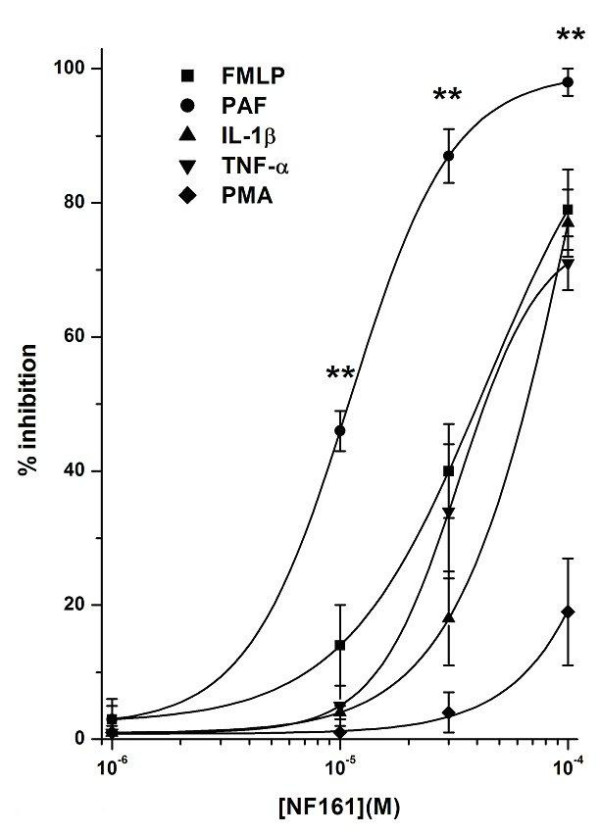
Effects of NF161 on PMN adhesion to HUVEC evoked by PAF, FMLP, IL-1β, TNF-α and PMA. HUVEC were pretreated with increasing concentrations (10-6–10-4M) of the tested compound for 10 min at 37°C and then challenged with PAF, FMLP (both at 10-7M) or PMA (10-8M) and PMNs for a further 10 min; IL-1β and TNF-α (both at 10 ng/ml) were incubated 1 h with the pretreated HUVEC and then challenged with PMNs for a further 10 min. Data are expressed as percentage inhibition versus control adhesion. Control adhesion was 51 ± 9 cells/microscope field (mean ± SEM, n = 26). PAF, FMLP, IL-1β, PMA and TNF-α stimulation vs control was, respectively: 305 ± 37%, 283 ± 28%, 270 ± 23%, 340 ± 46% and 304 ± 29%. Data are expressed as means ± SEM; n = 5. IC50 values were: 9.2 ± 0.7 × 10-6M, 3.7 ± 0.3 × 10-5M, 6.4 ± 0.4 × 10-5M and 3.1 ± 0.5 × 10-5M when the stimulus used was PAF, FMLP, IL-1β and TNF-α, respectively. IC50 values obtained with PAF were statistically different from all others (P < 0.01). Asterisks mark statistically significant inhibition of NF161 using PAF as stimulus versus all other stimuli (**P < 0.01).